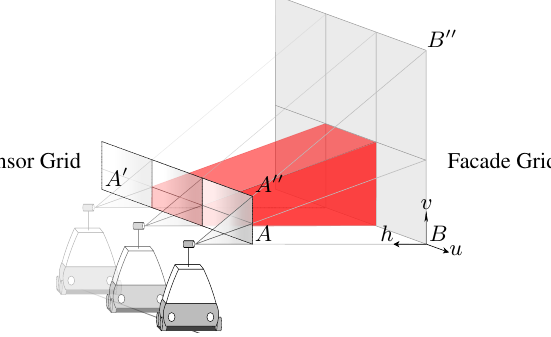
Figure 6: The points are accumulated in the pixels of the facade grid. The accumulation volume of a given pixel is shown in red. It extends to infinity behind the grid.